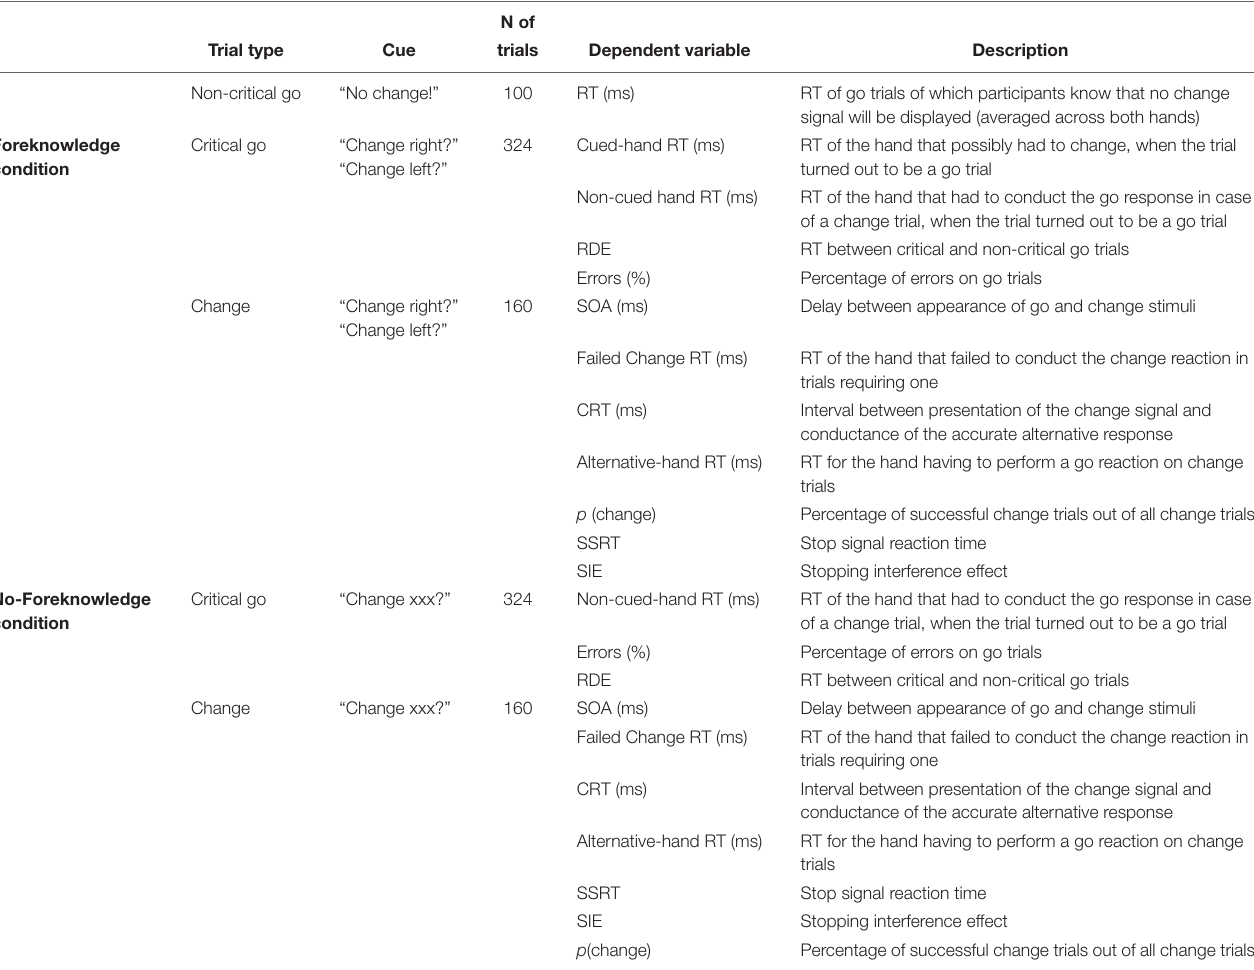
TABLE 1 | Experimental conditions and dependent variables.